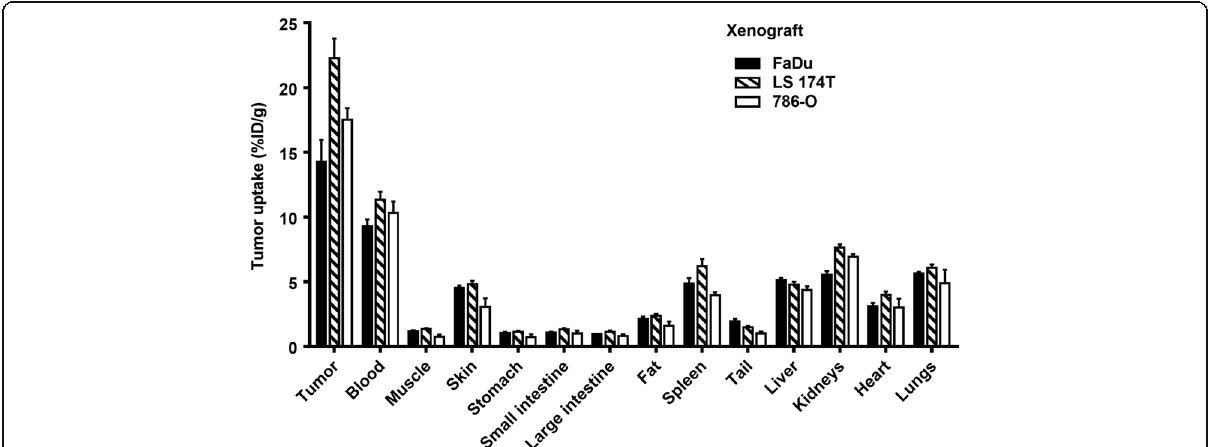
Fig. 2 Distribution of 111 In-bevacizumab after 5 days in mice bearing different tumour xenografts. Black = FaDu, hatched = LS 174T, white = 786-O. Data are presented as mean±SEM, n =minimum of 4